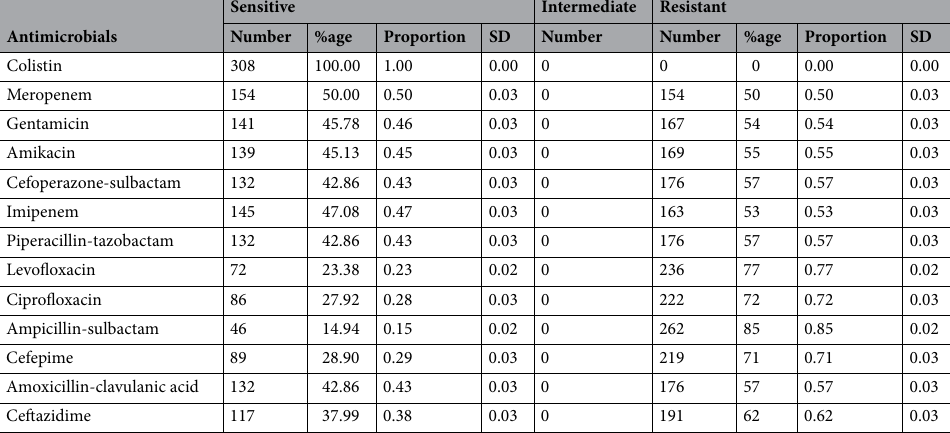
Table 2. Antimicrobial sensitivity pattern against P. aeruginosa from burn wound patients (N = 308).